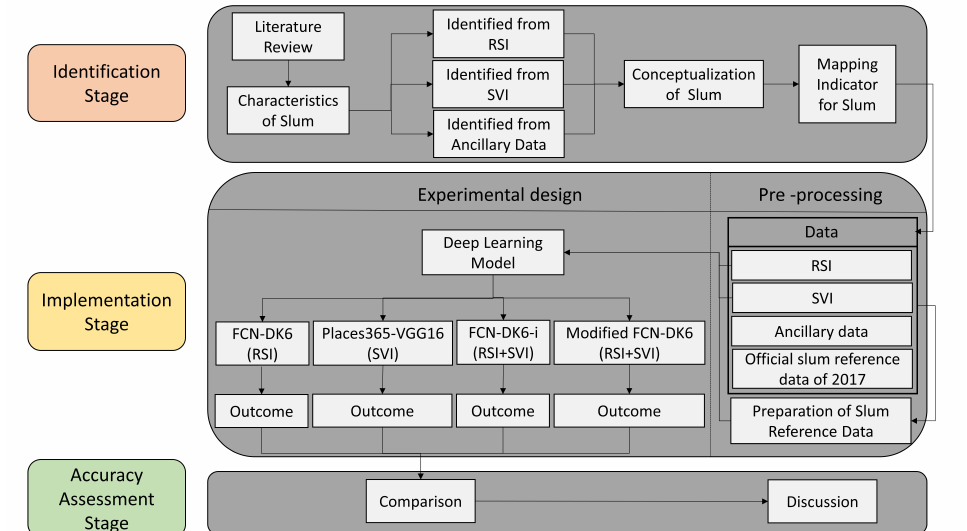
Figure 5. An overview of the methodological workflow shown over three stages: identification, implementation and accuracy